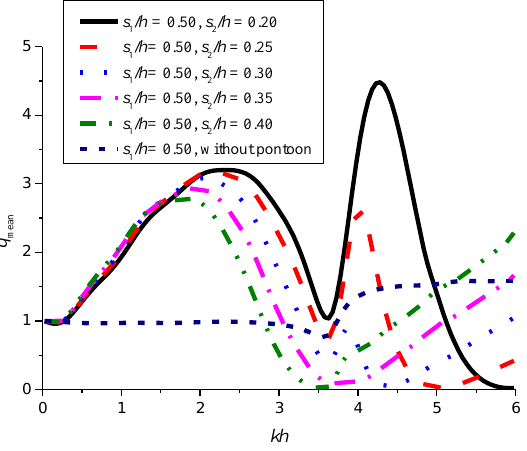
Figure 5. Variations of mean interaction factor q mean with the dimensionless wave number kh for different WEC-pontoon spacing s 2. Energies 2018 , 11 , x